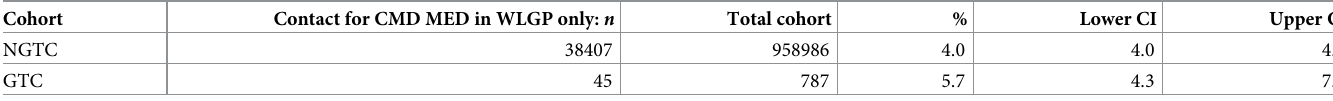
Table 5. Individuals with prescription for anxiety or depression medication in primary care data, with no further service contacts. Cohort Contact for CMD MED in WLGP only: